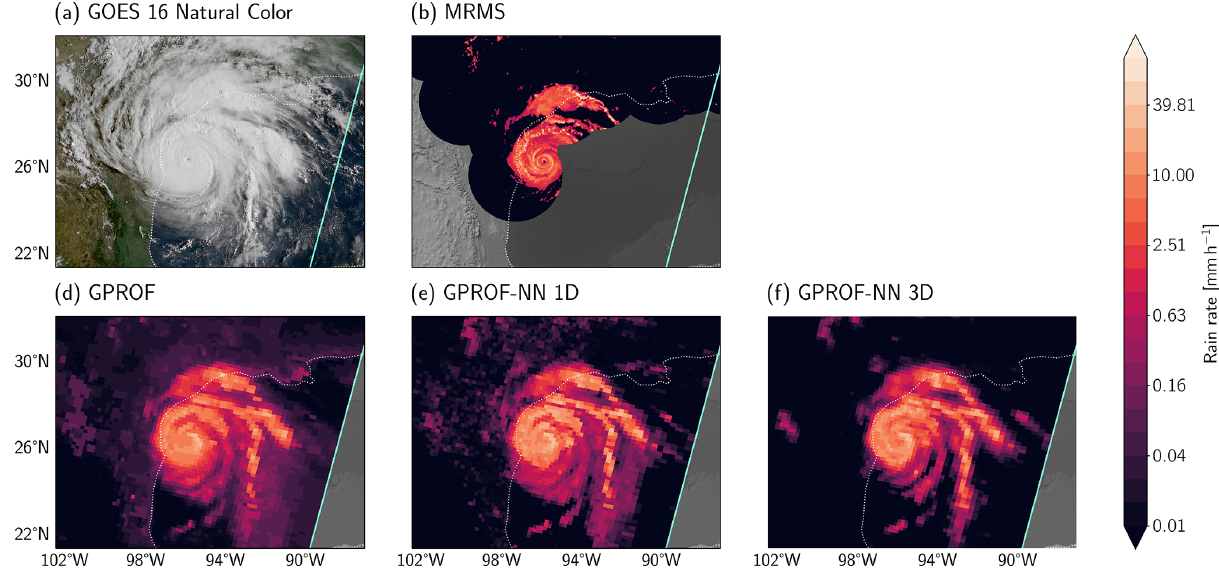
Figure 13. Surface precipitation during Hurricane Harvey on 25 August 2017 at 13:58:00UTC retrieved from MHS on NOAA-18. Panel (a) shows a natural color composite from the ABI on GOES 16 (generated using the natural_color composite in Satpy; Raspaud et al., 2021). Panel (b) shows ground-based precipitation measurements from MRMS for which the radar quality index is at least 0.8. Panel (c) shows retrieved surface precipitation from the CMB product. Panels (d) , (e) , and (f) show the retrieved surface precipitation fields from GPROF, GPROF-NN 1D, and GPROF-NN 3D,